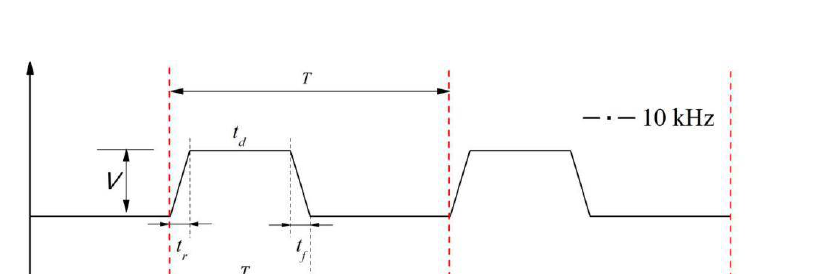
Figure 1. ( a ) Schematic of experimental setup; ( b ) schematic of nozzle.